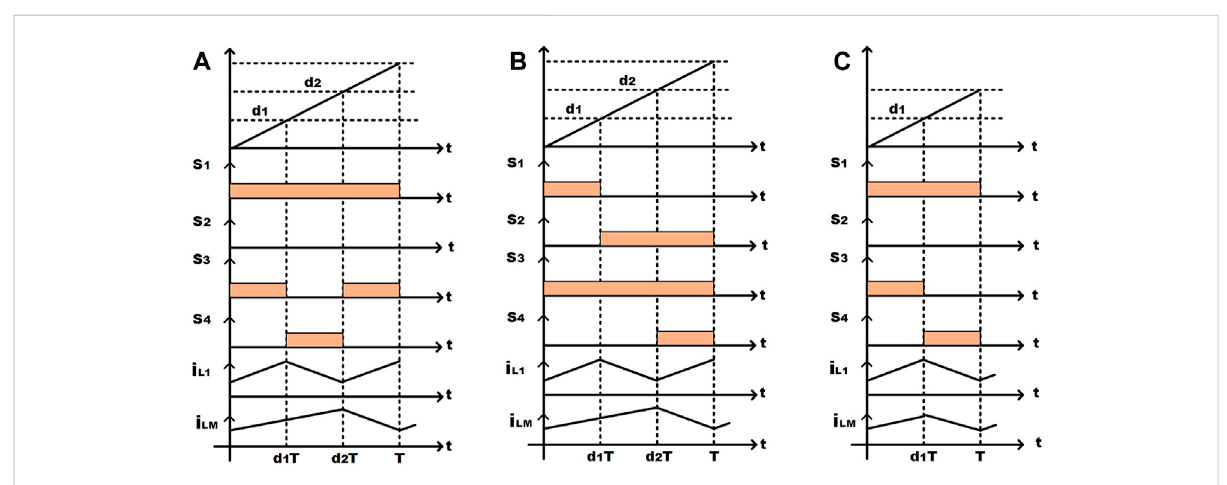
FIGURE 4 Three states in a switch sequence: (A) state-1, (B) state-2, and (C)